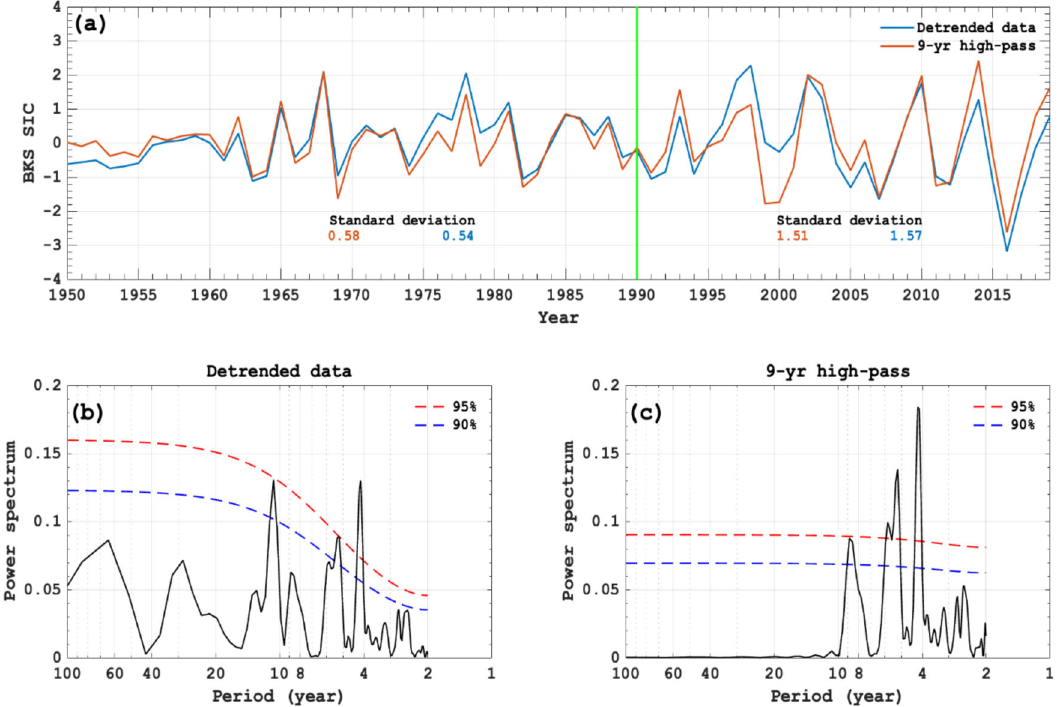
Fig. 1 | Temporal variabilityand power spectra ofthe winter Barents-Kara sea- ice for detrended and 9-year highpass fi ltered data.a Normalizedtime series of DJF (December-February) mean sea ice concentration (SIC) anomaly (%) averaged overtheBarents-KaraSeas(BKS)(30° – 90°E,65° – 85°N)forlinearlydetrended(blue line, no fi ltering) and 9-year (or 9-yr)high-pass fi ltered (red line) SIC data from the